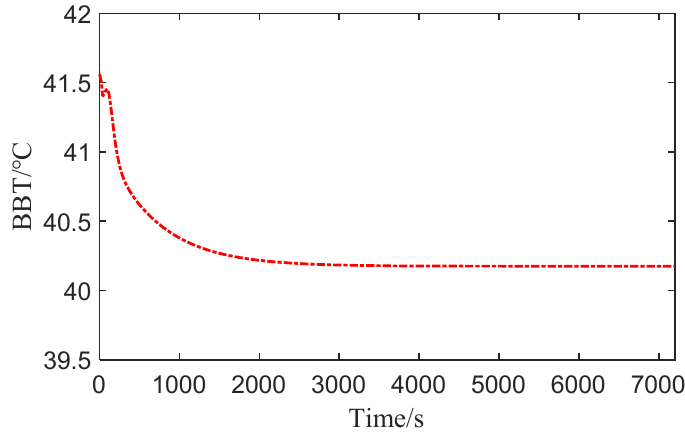
Figure 5. Bottom brine temperature ( BBT) dynamic response with time.